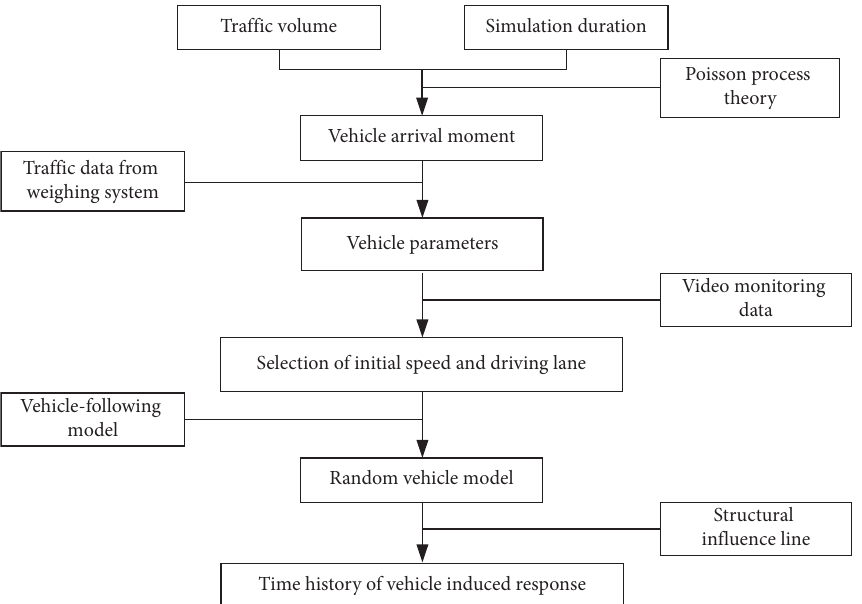
Figure 5: The establishment procedure of the random vehicle